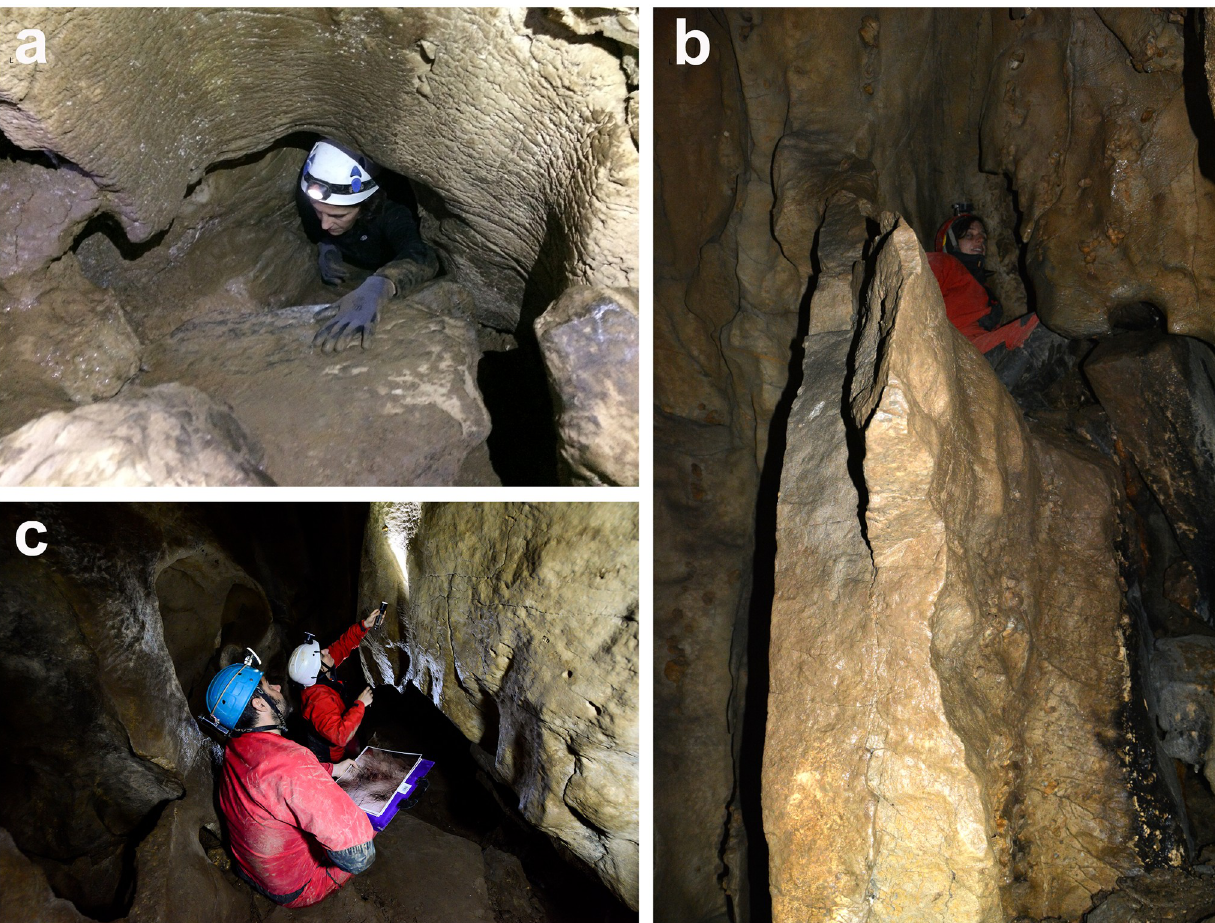
Fig 3. Working conditions in the decorated passage in Aitzbitarte Cave III: a) Access to the sink-hole leading to the passage; b) descent to the decorated area; c) archaeological recording process of the engraved walls (S. Laburu).